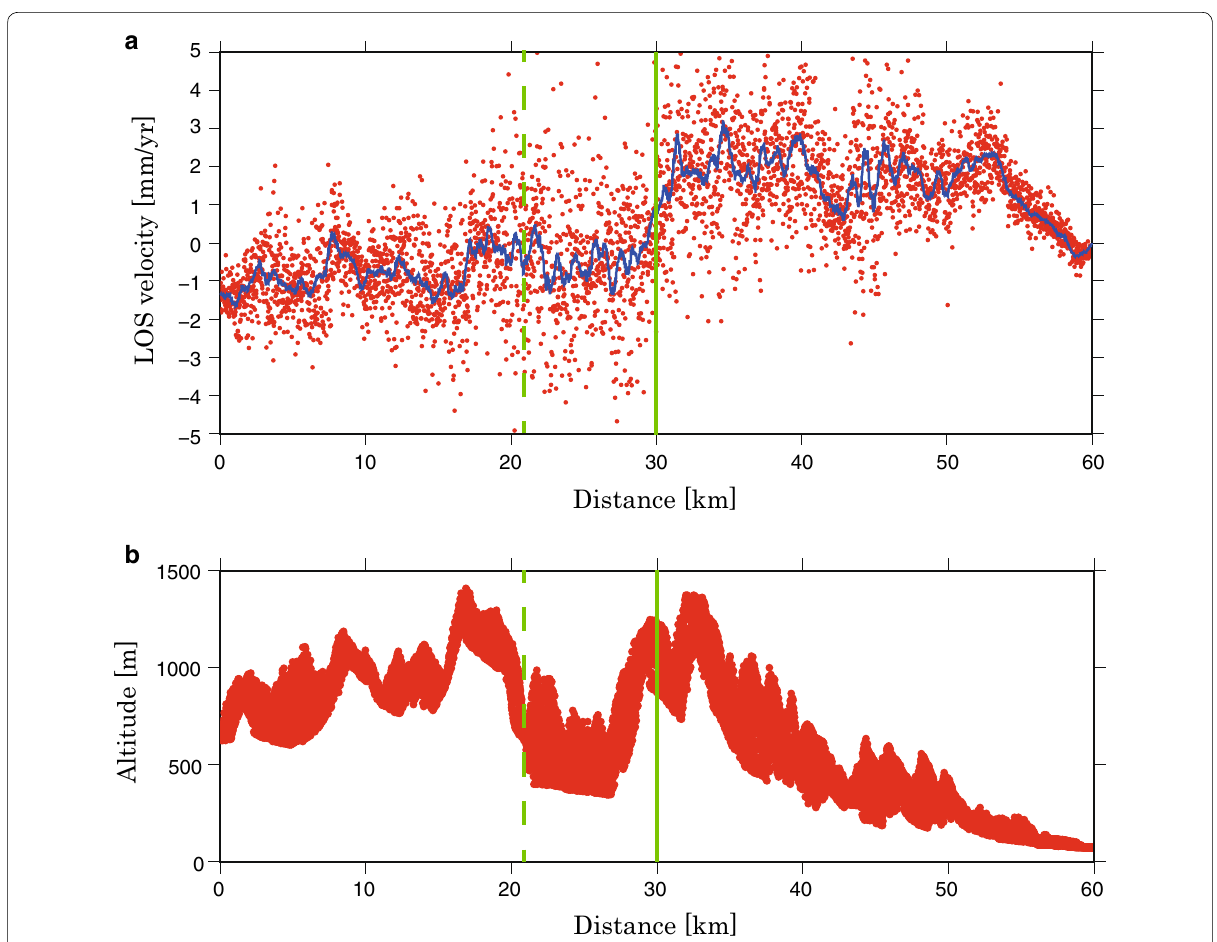
Fig. 8 Profiles of a LOS velocities and b altitudes along AA’ in Fig. 7. Blue line indicates 30 points running average. Green solid and broken lines at ~ 30 km and ~ 21 km along the horizontal axis indicate the location of the Ushikubi and Atotsugawa faults,